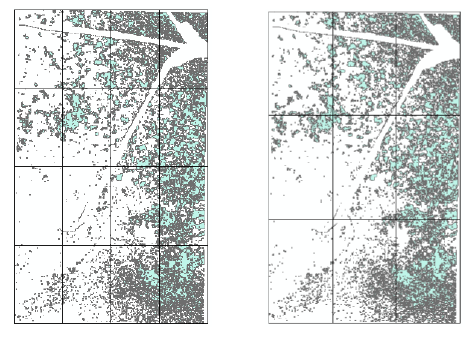
Figure 5: Classified Image after using the Fishnet Tool in